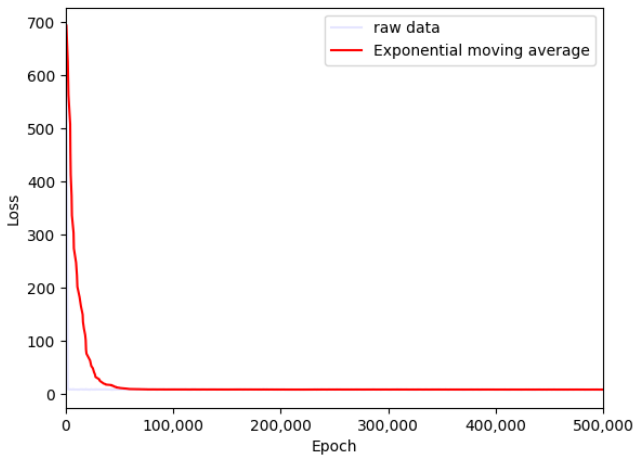
Figure 6. Loss function of simulation LSTM training.